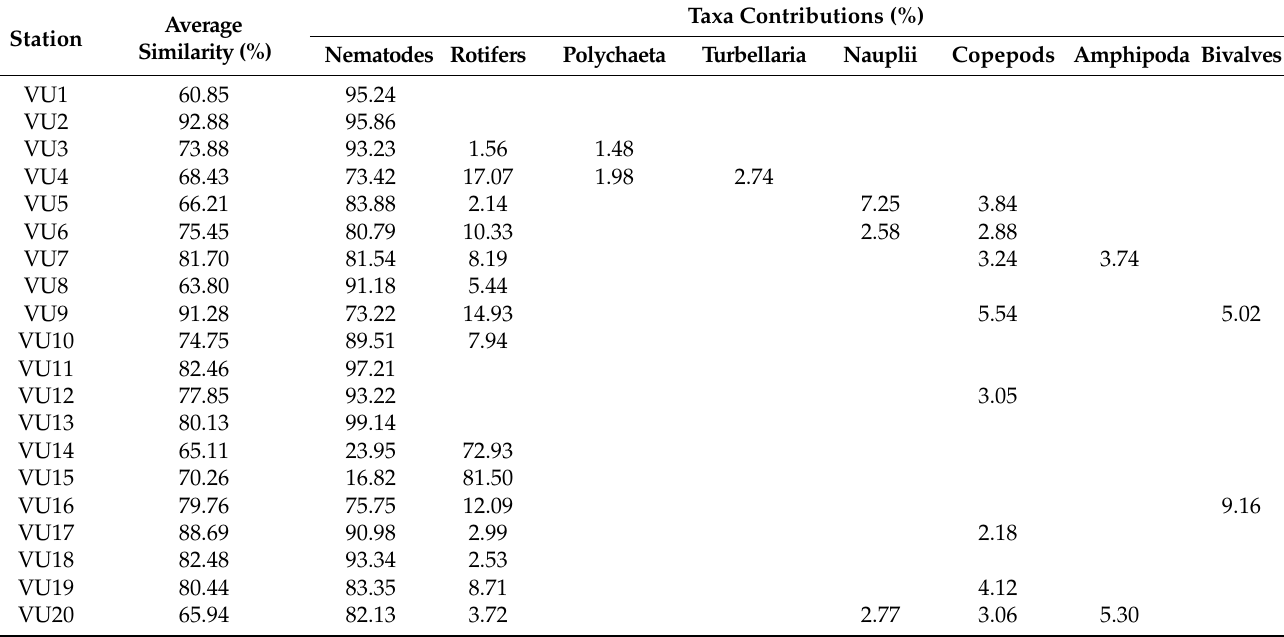
Table 4. Results of the SIMPER